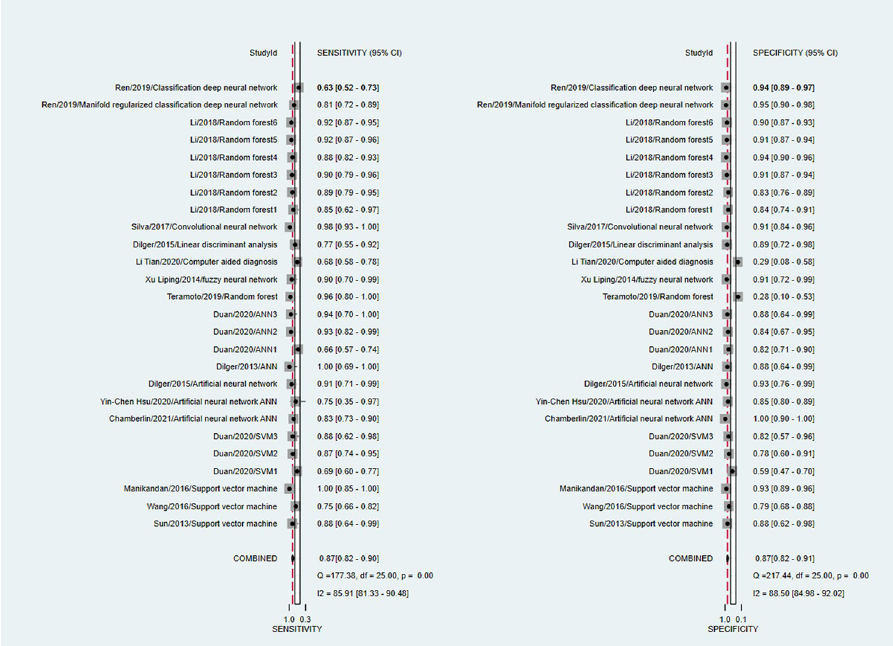
Fig 5. Forest plot of sensitivity and specificity of AI-aided diagnosis for lung cancer